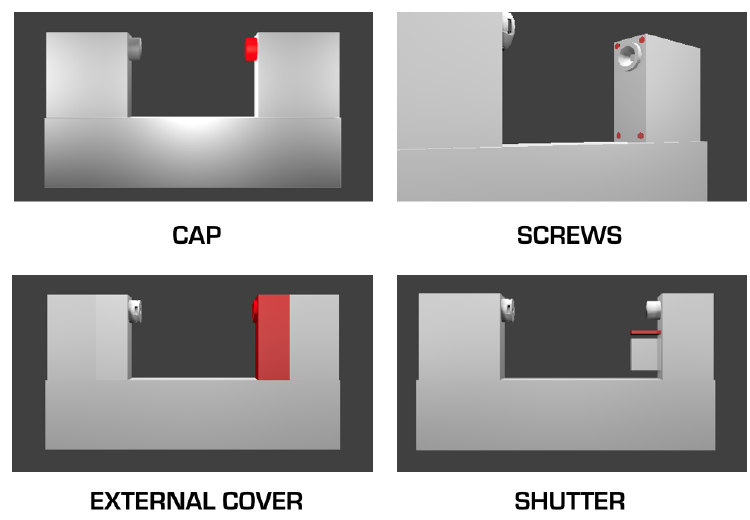
Figure 10. Relevant components for the industrial calibrator procedure.